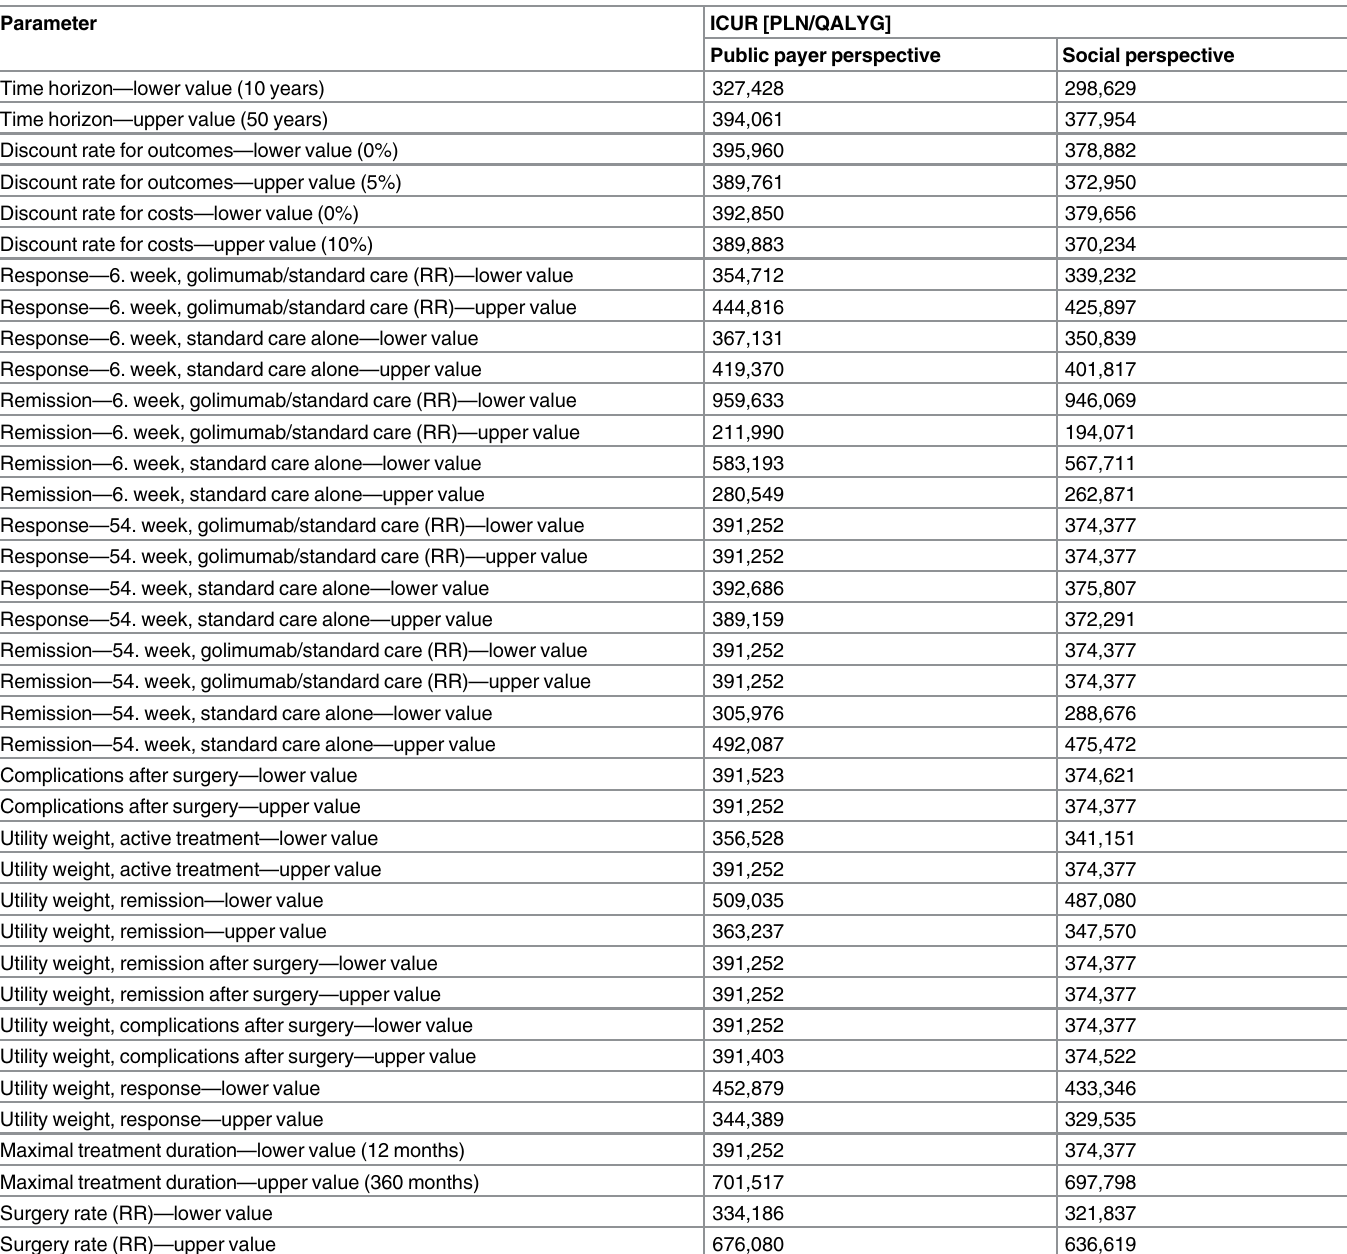
Table 4. Sensitivity analysis